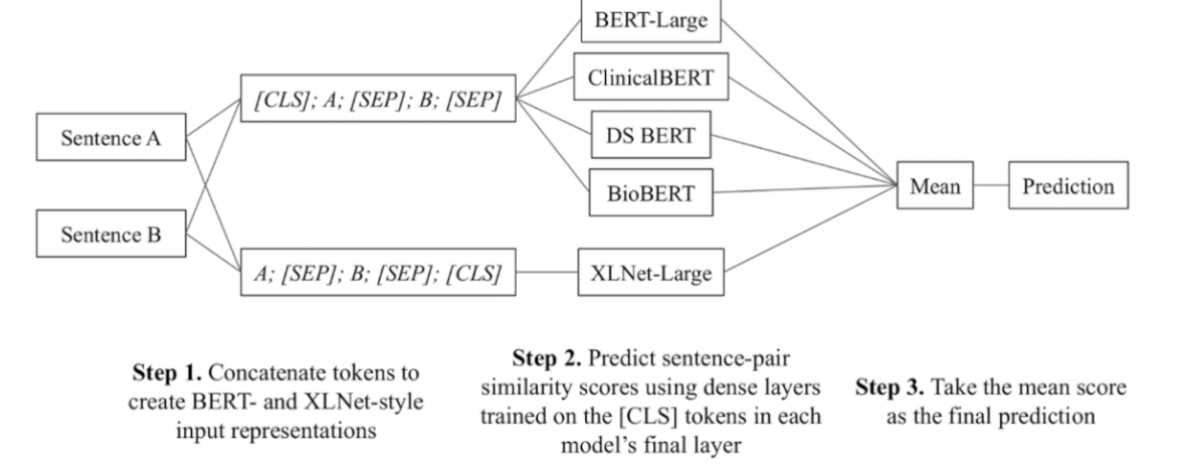
Figure 1. Our system architecture for predicting the semantic textual similarity between two sentences using an ensemble of five Transformer models.